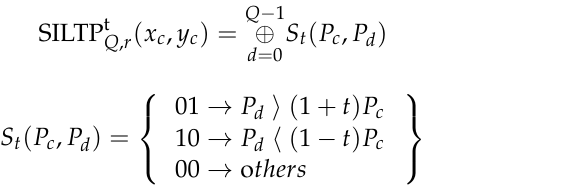
Figure 5. LBP operator coding process diagram.